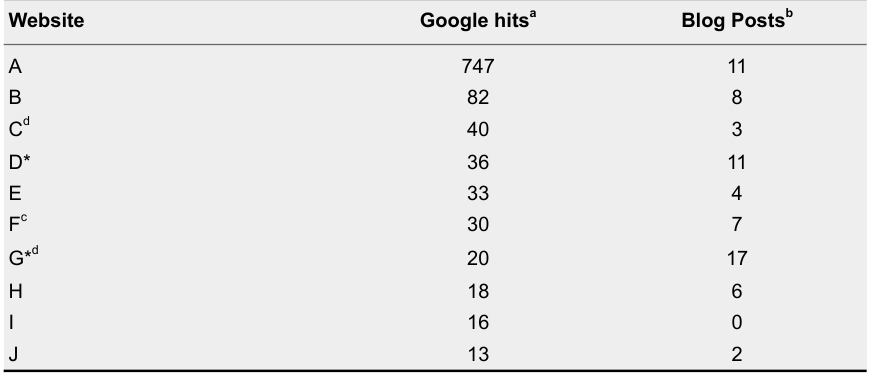
Principal Web Sites Involved in Blogosphere’s Response to the Publication of LOG12